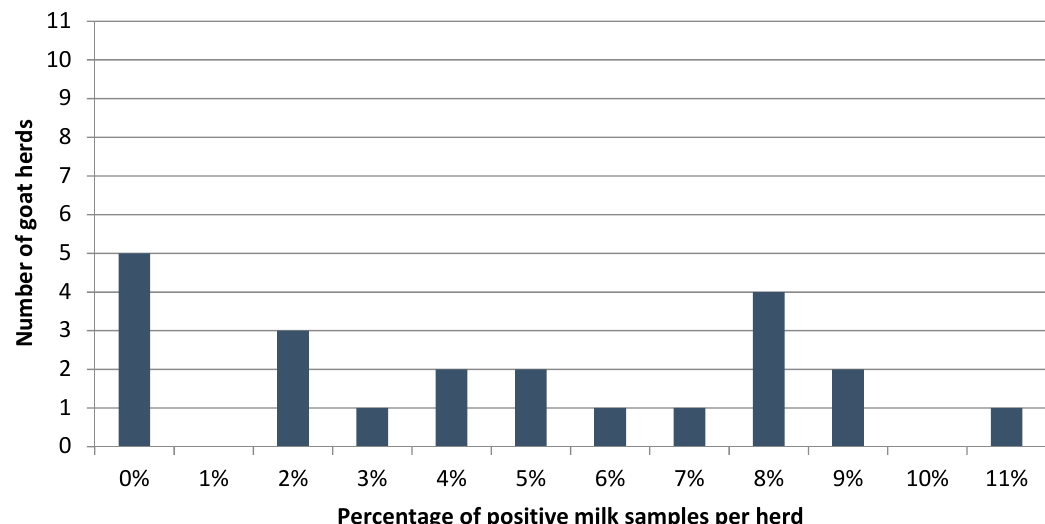
Figure 2. Distribution of the percentage of positive milk samples using a MAP ELISA with a cut-off of 25 S/P% based on 2464 randomly selected milk samples from Dutch dairy goats on 22 conventional herds. Table 1. MAP ELISA results for milk samples from 1518 vaccinated and 900 nonvaccinated Dutch dairy goats, using a cut-o ff of 25 S /